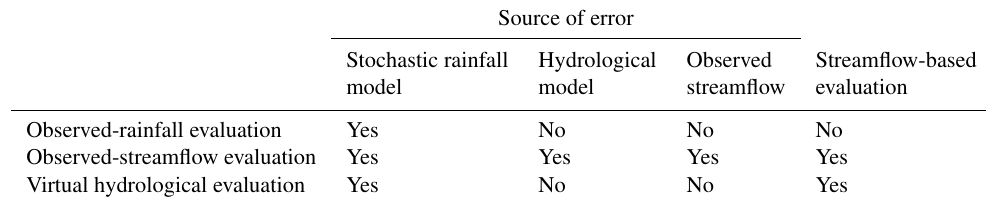
Table 1. Comparison of the sources of error for observed-rainfall, observed-streamflow and virtual hydrological evaluation frameworks as well as whether the evaluation is streamflow-based. Source of error Stochastic rainfall Hydrological Observed Streamflow-based model model streamflow evaluation Observed-rainfall